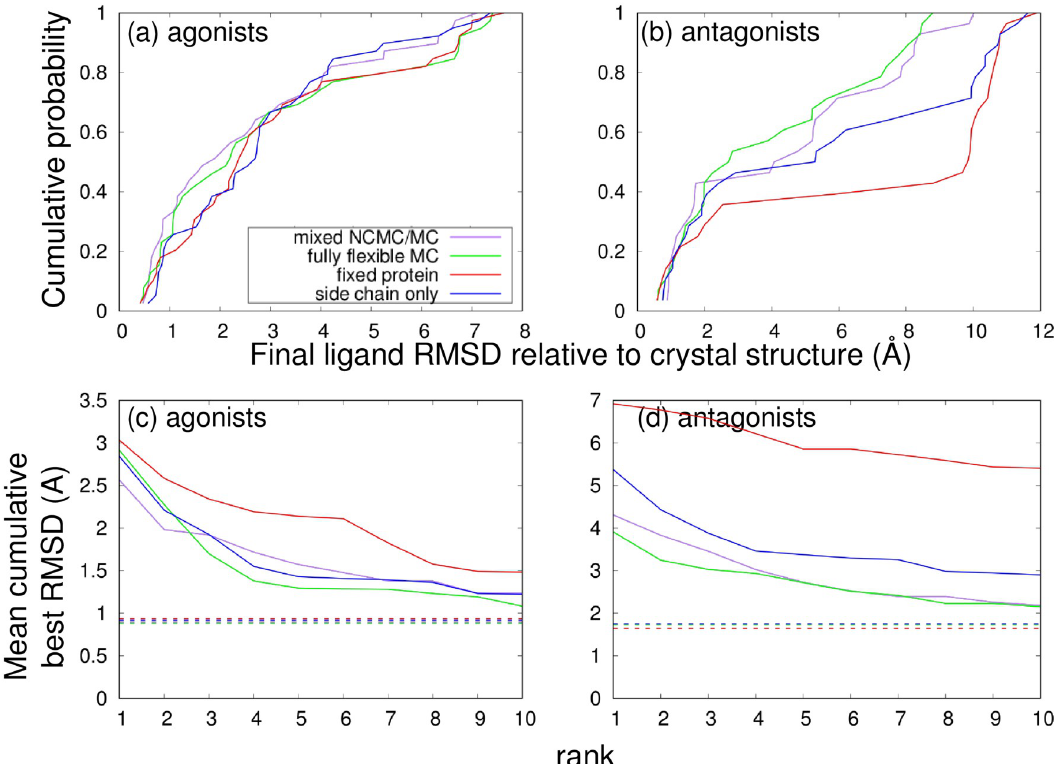
Fig 6. Performance of docking protocols. (a) and (b) show the cumulative probability distribution of RMSD values for the docked poses with the lowest final interaction energies for each drug, for (a) agonists or (b) antagonists. Larger values at low RMSD indicate better performance. In (c) and (d), for each drug the docking runs with the N lowest interaction energies are chosen and the best RMSD from among these is averaged across (c) agonists or (d) antagonists, so that lower RMSD indicates better performance. This average RMSD is plotted against N ; dashed horizontal lines indicate the average best RMSD overall, without regard for interaction energy.